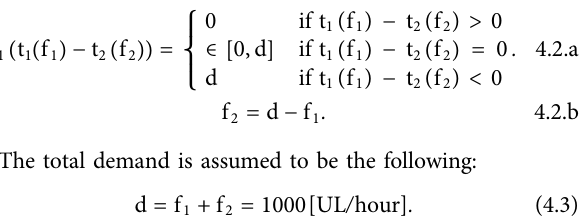
Frontiers in Future Transportation |